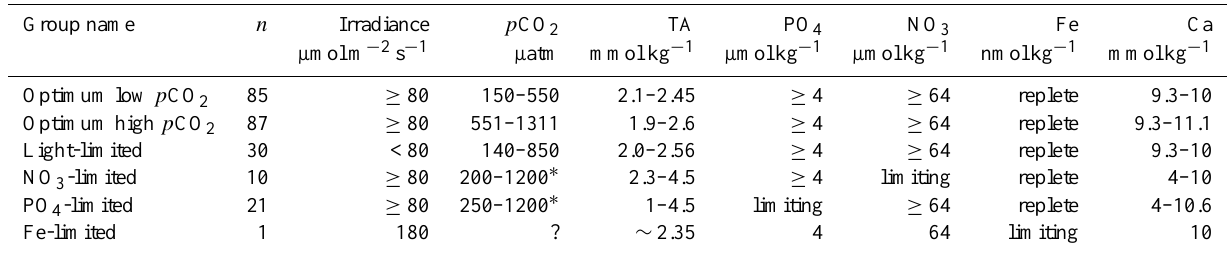
Table 2. Subgroups of experiments and the experimental conditions that define them. Group name